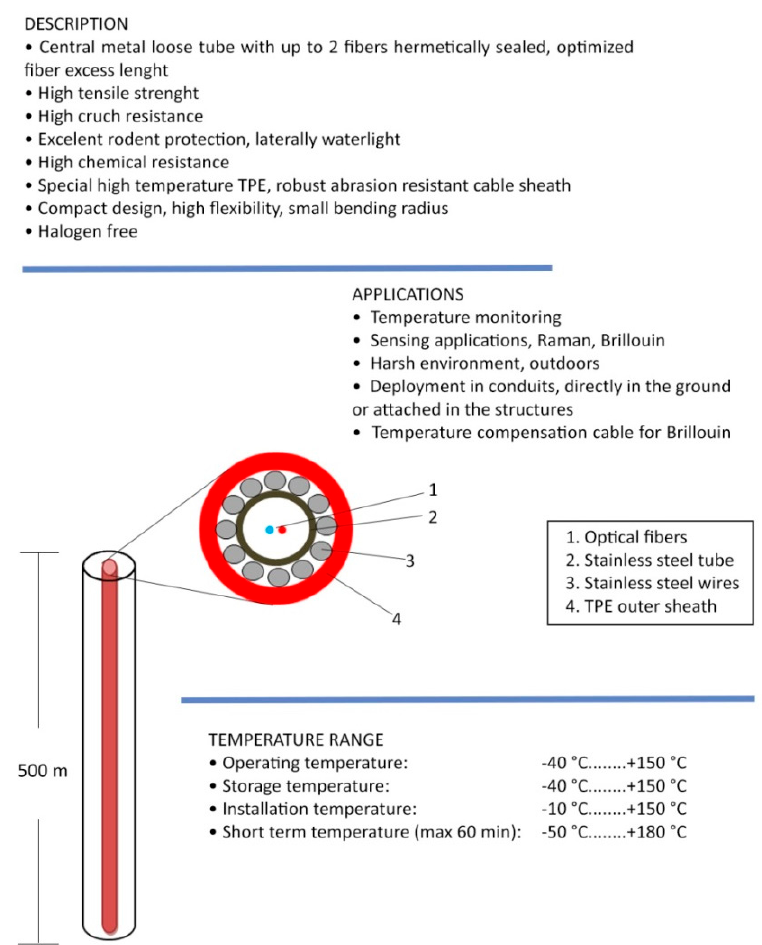
Figure 3. Small fiber optic mid temperature sensing cable, armored with stainless steel loose tube, stainless steel strength members and TPE outer sheath, fast thermal response up.